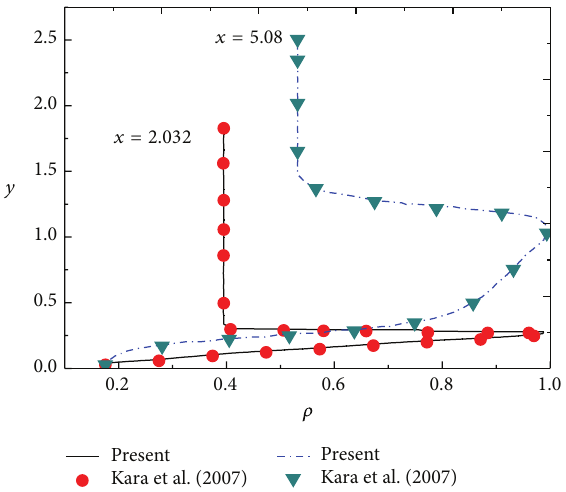
Figure 2: Comparison of the real part of Fourier transform for pressure disturbance with Zhang et al.’s result.